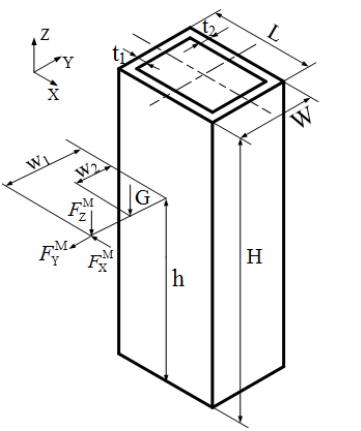
Figure 3. Mechanical analysis of the column structure.